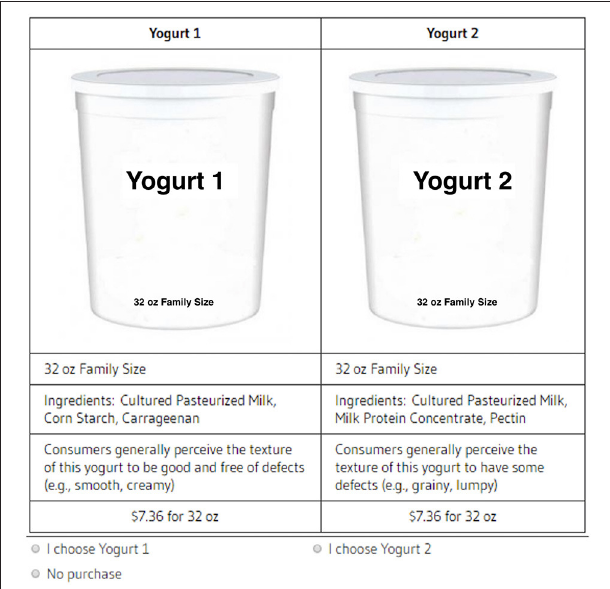
FIGURE 1 | Choice set